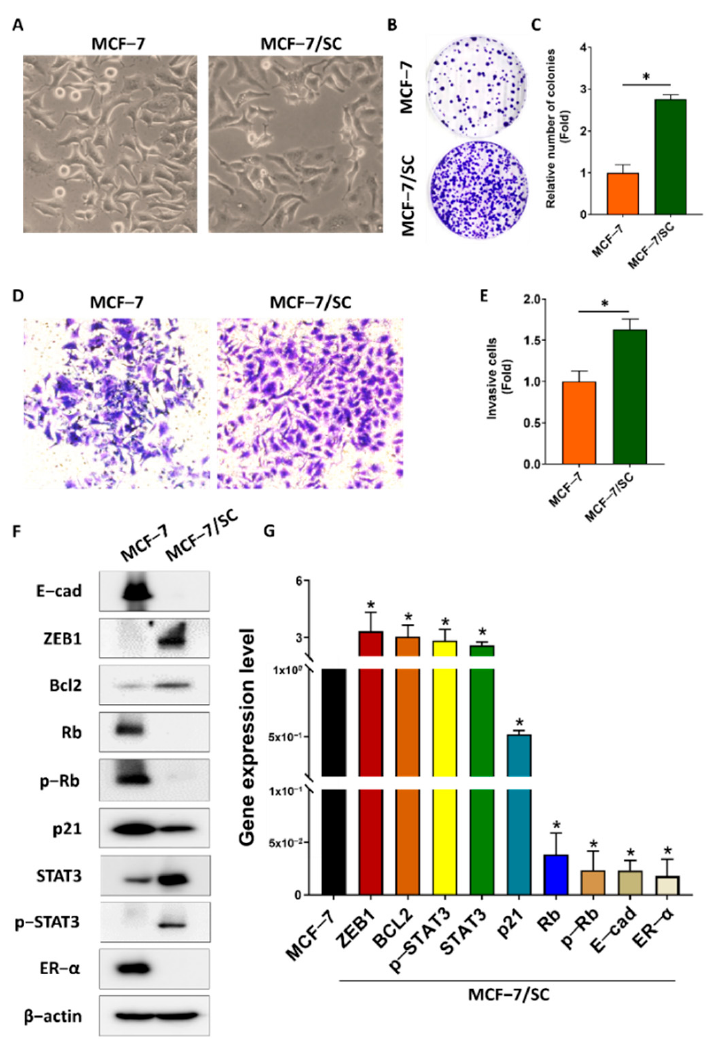
Figure 1. Characterization of drug − resistant human breast cancer MCF − 7/SC cells. ( A ) Comparison of morphology between MCF − 7 and MCF − 7/SC cells. ( B , C ) The number of colonies and ( D , E ) invasive cells analyzed to compare MCF − 7 and MCF − 7/SC cells. ( F ) Representative Western blot analysis for drug resistance markers. ( G ) Real − time PCR was performed to access the gene expression. β− actin was used as a loading control. The asterisk (*) indicates p < 0.05 vs. the control. Data are representative of three biologically independent experiments and values are shown in mean ± SD.